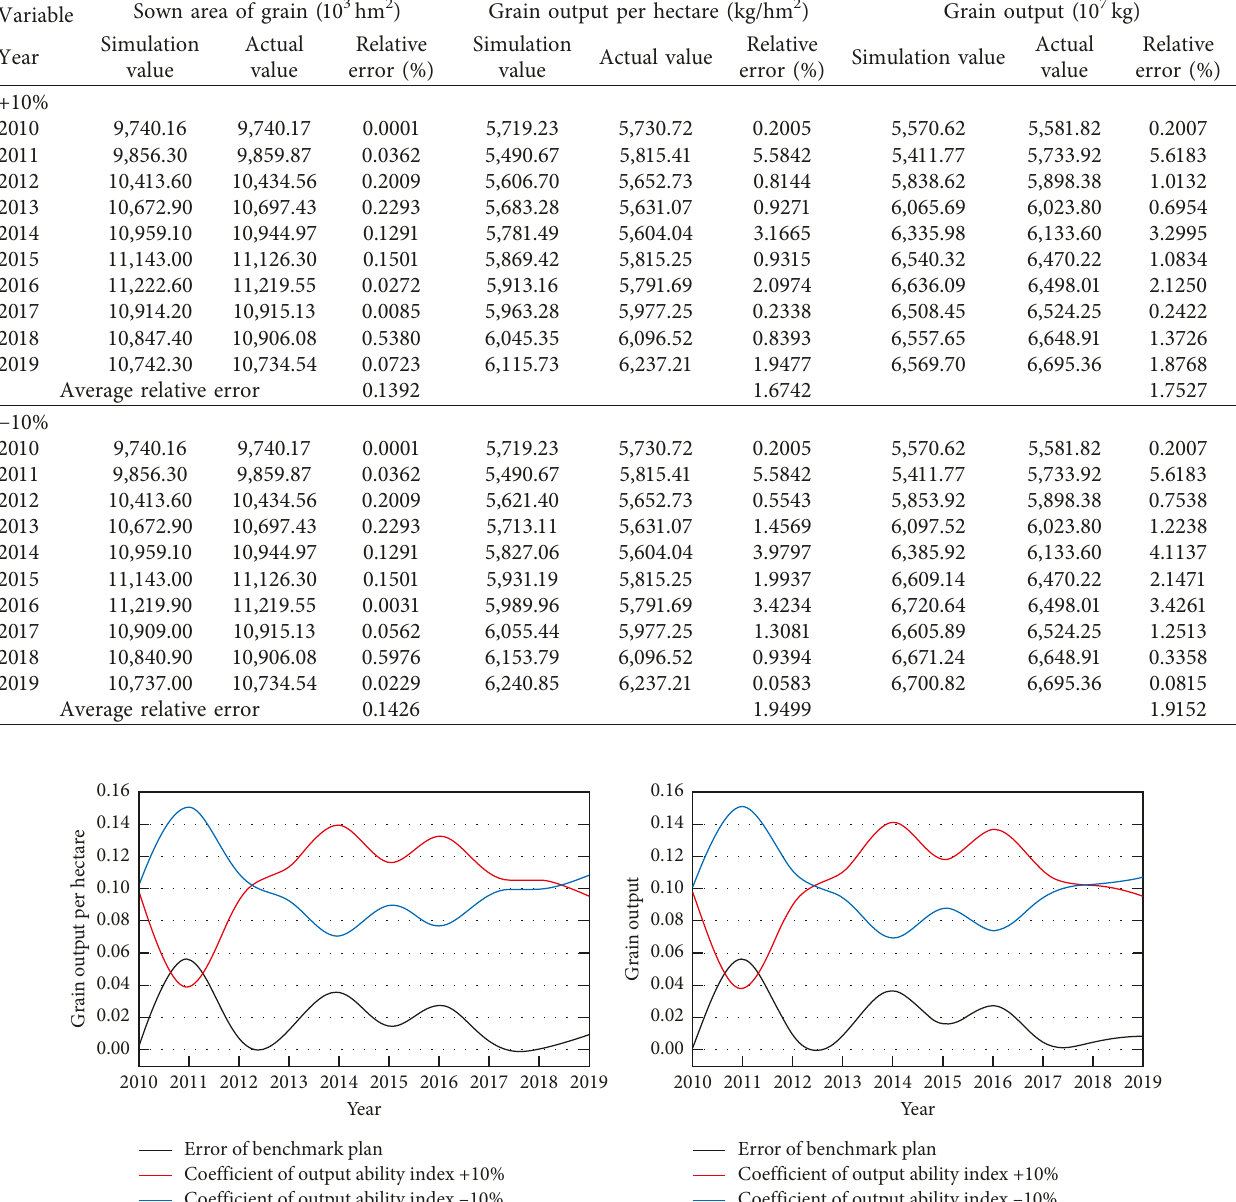
Figure 3: Error trend diagram of adjustment of output ability index